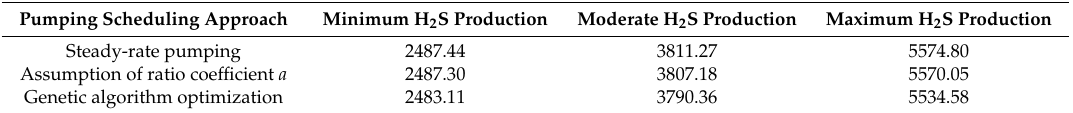
Table 1. Values of the MZ c index for three different pumping scheduling approaches and loading scenarios.